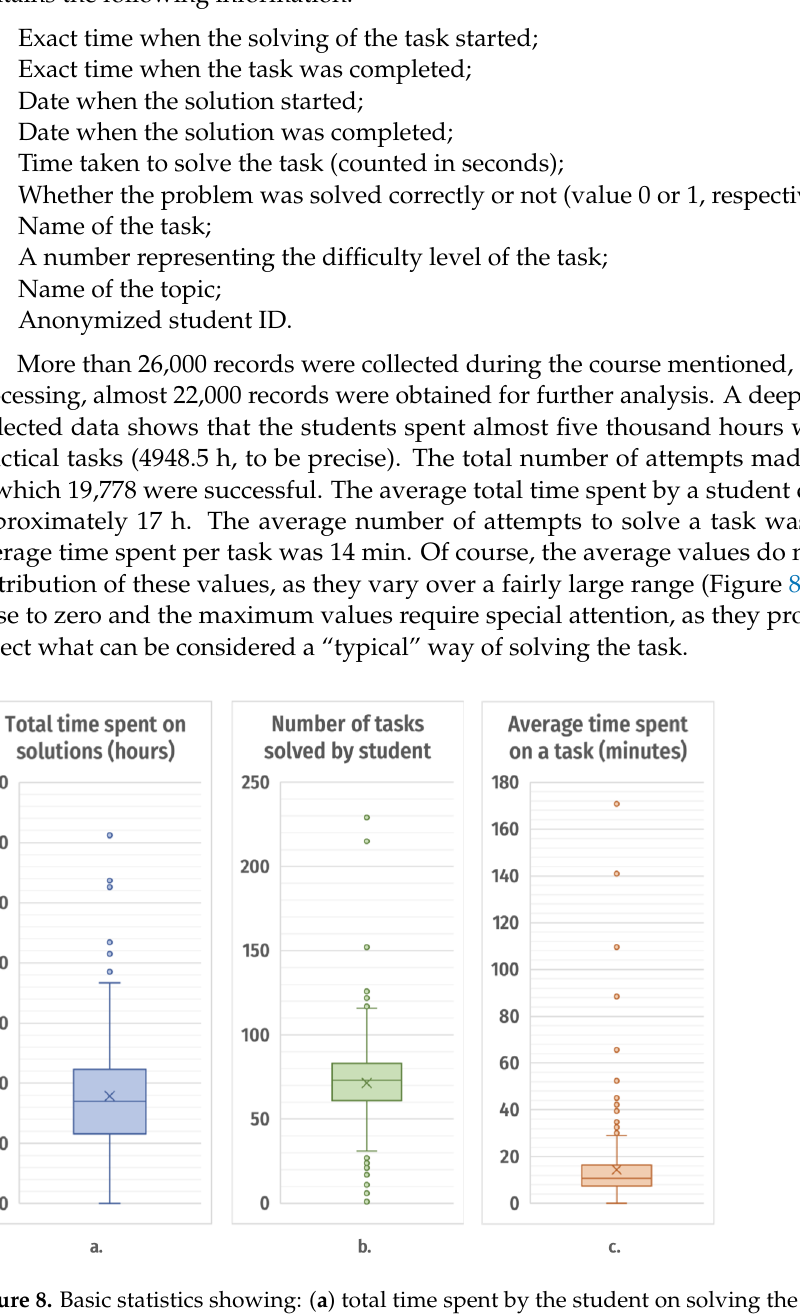
Figure 8. Basic statistics showing: ( a ) total time spent by the student on solving the tasks; ( b ) total number of tasks solved by the student; and ( c ) average time taken to solve the